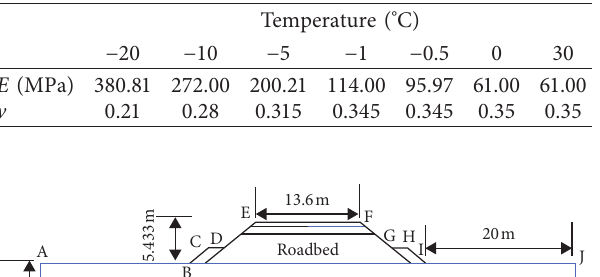
Table 3: Mechanical parameters of roadbeds.